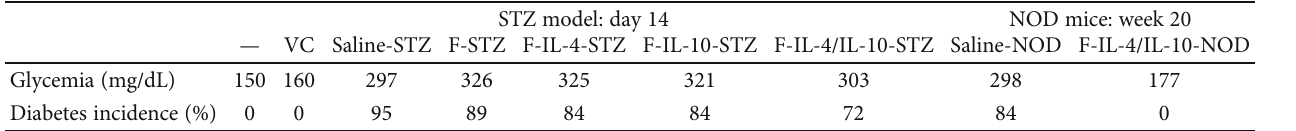
Figure 3: Clinical e ff ects of genetically modi fi ed L. lactis strains encoding IL-4 and IL-10 in the NOD mouse model. NOD mice were i.g. administered L. lactis MG1363 FnBPA + (pValac::dts:: IL-4 ) and L. lactis MG1363 FnBPA + (pValac:: IL-10 ) suspension (F-IL-4/IL-10-NOD group) or 0.9% saline (saline-NOD group) 5 days/week from week 5 to week 19. (a) Glycemic levels (mg/dL) were measured once a week from weeks 1 to 20. The data are shown as the mean ± SD of three independent experiments ( n = 12 ). (b) Diabetes incidence over time was analyzed, and (c) the percentage of diabetic and nondiabetic mice between the NOD mouse groups at the fi nal time point was compared. p value: p ≤ 0 : 05 . Table 2: Comparison of clinical parameters observed in STZ model mice and NOD